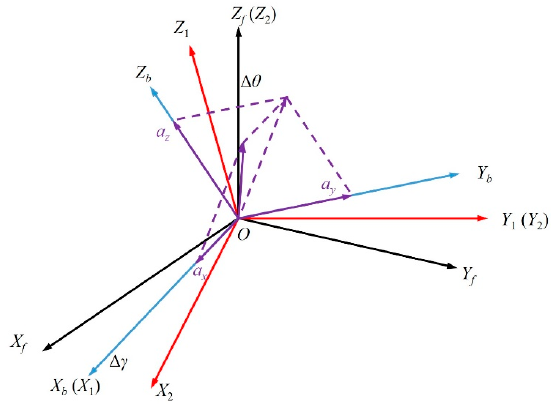
Figure 9. Roll deviation angle of SINS.